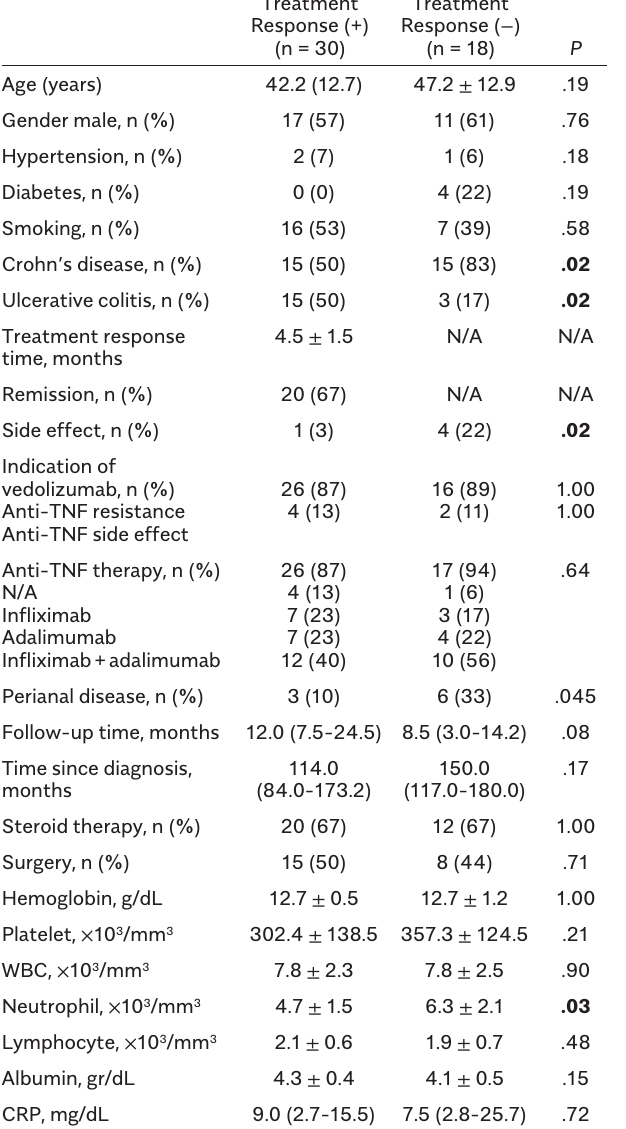
Treatment Response (+)